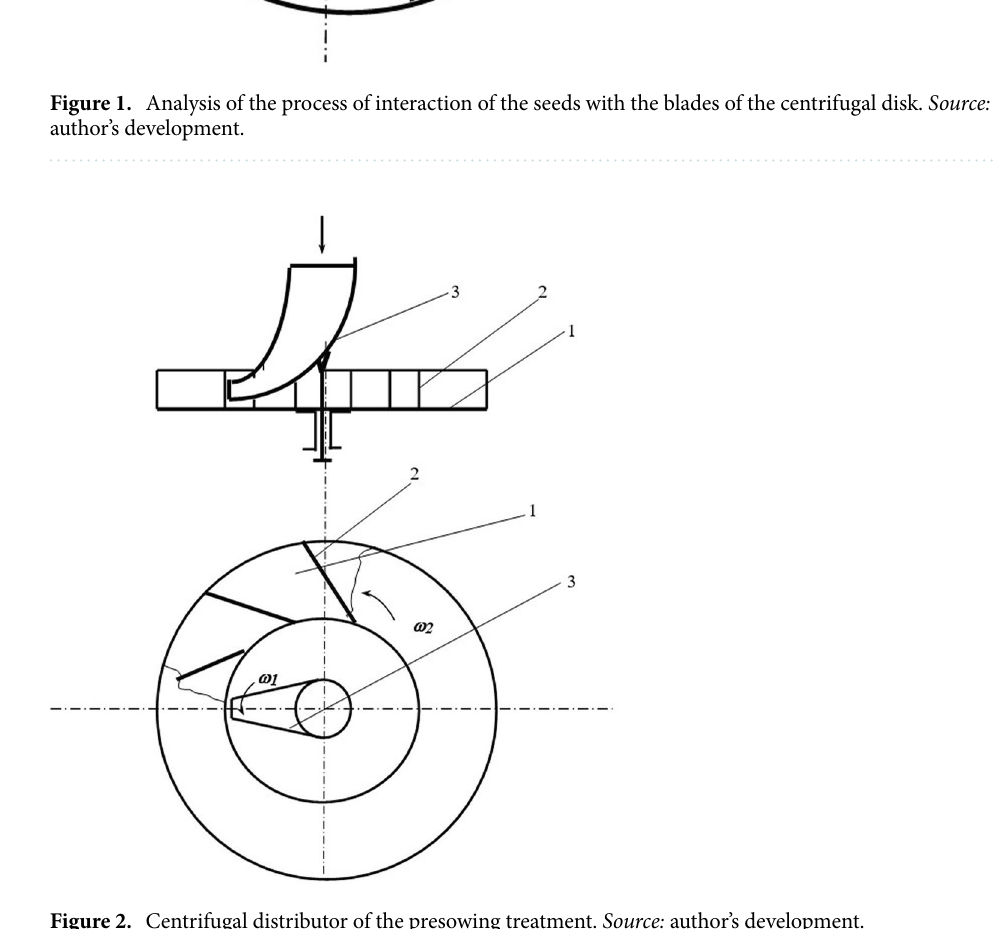
Figure 2. Centrifugal distributor of the presowing treatment. Source: author’s